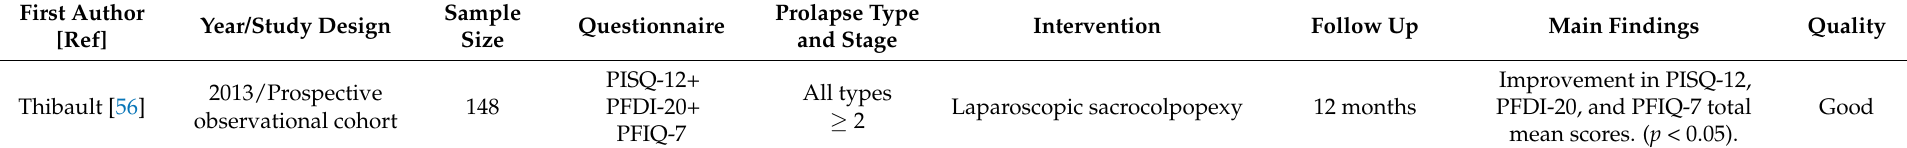
Table 5. The characteristics of the studies on the effectiveness of abdominal surgeries on the quality of life in women with pelvic organ